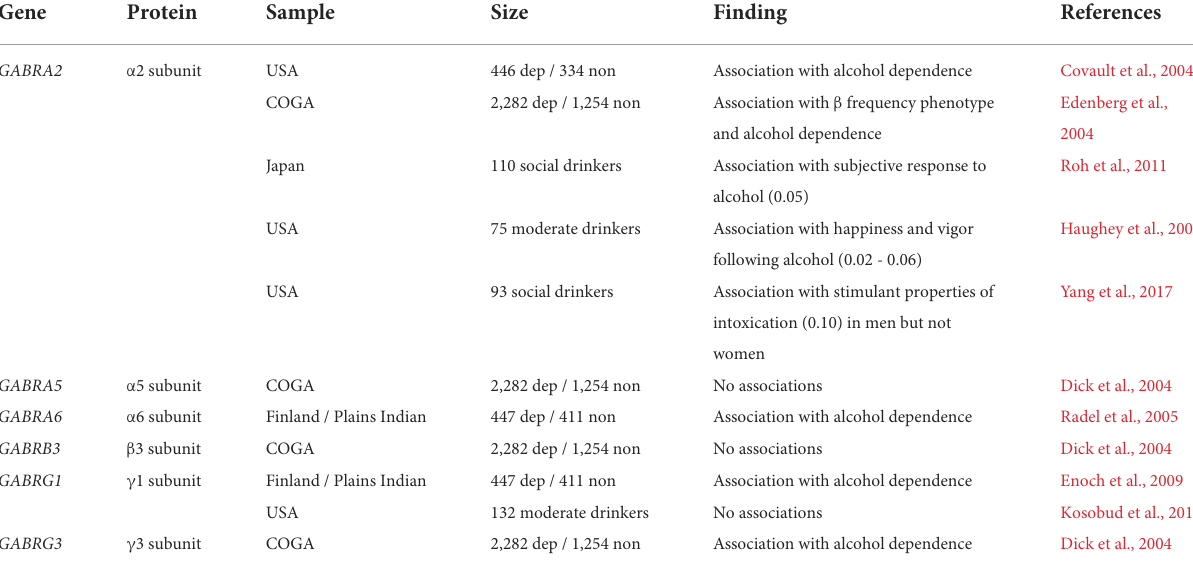
TABLE 1 Selected studies examining the association of GABA A receptor gene single nucleotide polymorphisms (SNPs) with drinking or AUD vulnerability.